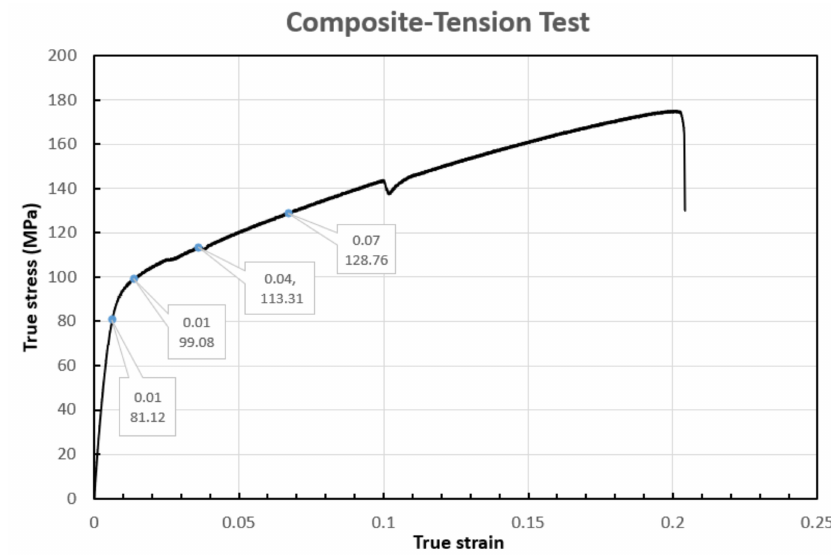
Figure 18. The experimental result of tension composite dog-bone with four unique points marked out with true stre ss and true strain.